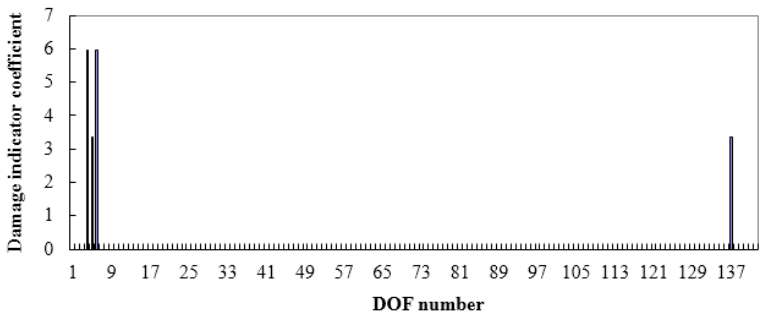
Figure 3. Damage indicator vector when long cable 31 was damaged.